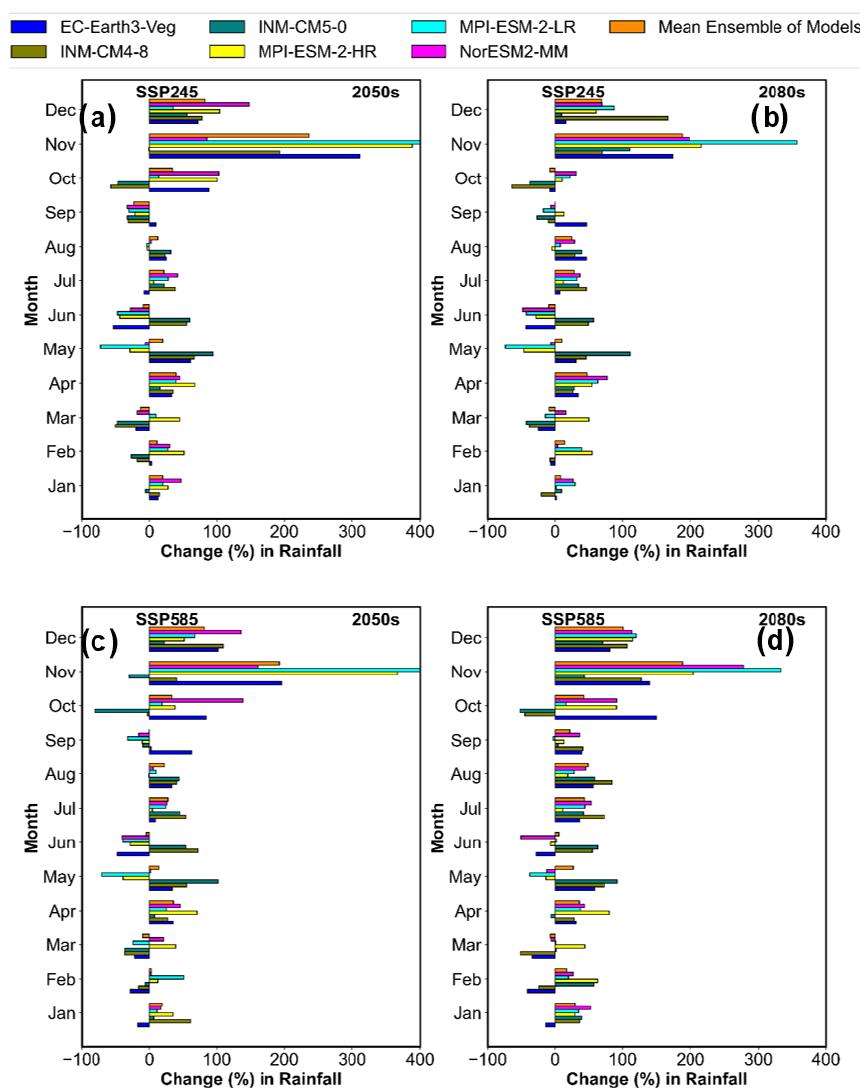
Figure 16. Predicted change in monthly streamflow pattern of the Sutlej River with respect to the reference period (1979–2009) in (a, b) 2050s and (c, d) 2080s under SSP245 and SSP585 scenarios for different CMIP6